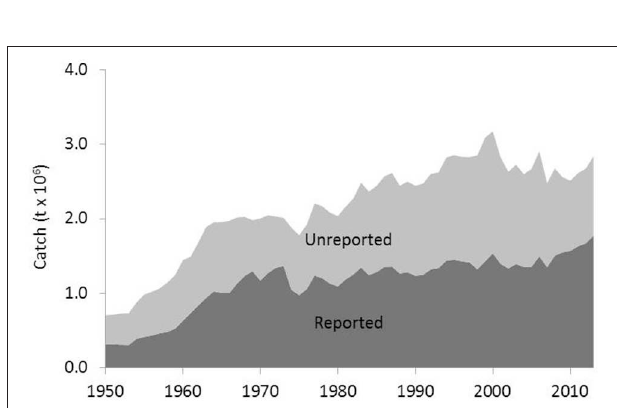
FIGURE 3 | Total reconstructed catches from four Southeast Asian countries.